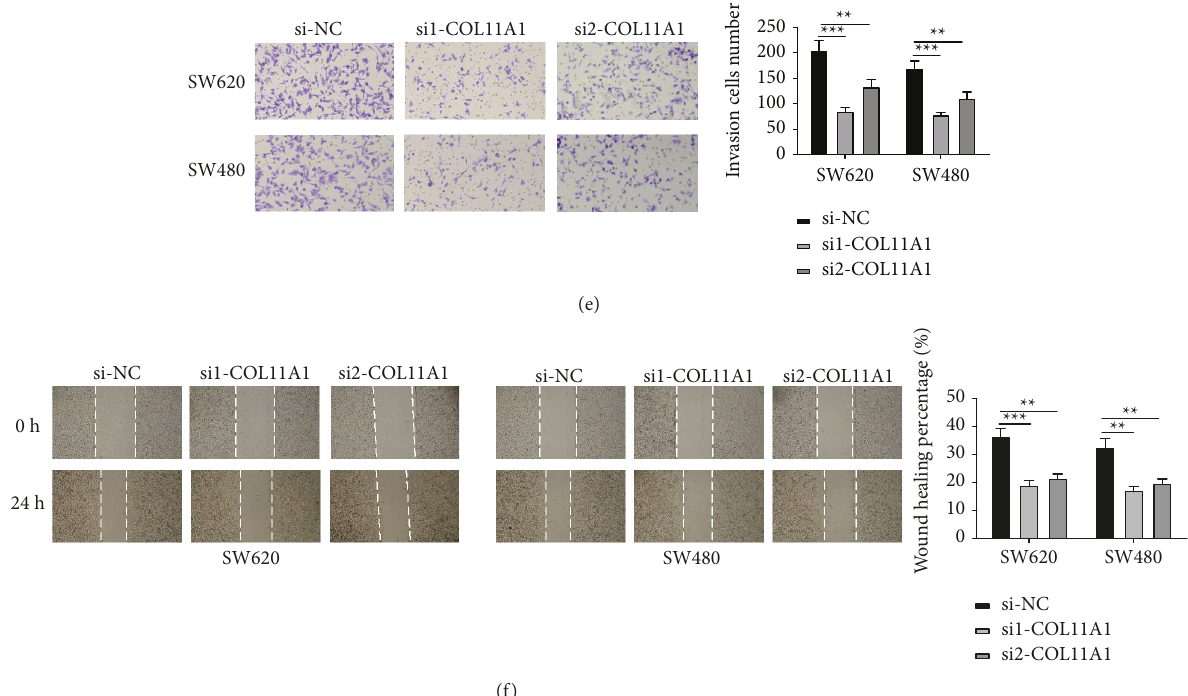
Figure 2: COL11A1 downregulation constrains colon carcinoma cell proliferation, migration, and invasion. (a) COL11A1 mRNA expression in SW620 and SW480 cells in si-NC and si-COL11A1 groups. (b) COL11A1 protein expression in SW620 and SW480 cells. (c) Viability of SW620 and SW480 cells. (d) Colony formation of SW620 and SW480 cells. (e) The invasive ability of SW620 and SW480 cells (100x). (f) The migratory ability of SW620 and SW480 cells (40x). ∗ p < 0 . 05, ∗∗ p < 0 . 01, ∗∗∗ p < 0 . 001, # p < 0 . 05, ## p < 0 . 01, ### p < 0 . 001, ∗ denotes the comparison between si-NC and si1-COL11A1; # denotes the comparison between si-NC and